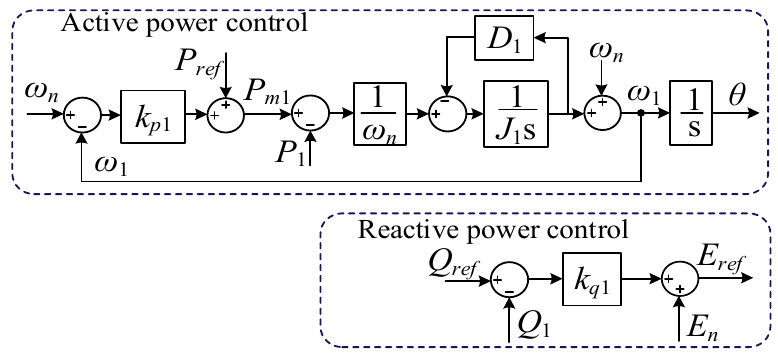
Figure 2. The VSG control diagram with active power and reactive power controller. According to Figure 2, the rotor motion equation can be expressed as